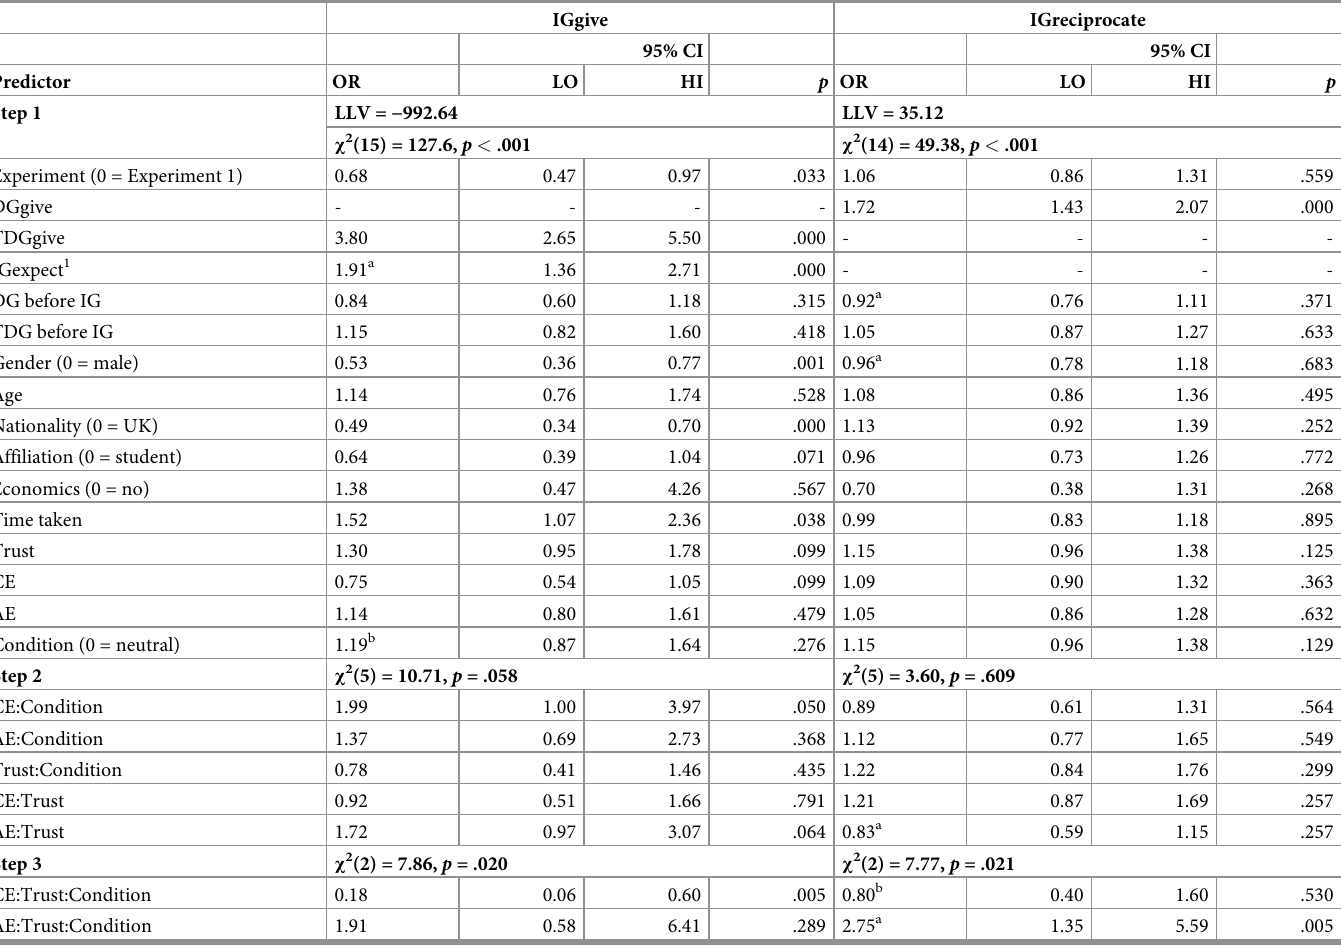
Table 3. Hierarchical ordered logistic and beta regressions predicting giving and reciprocating in the